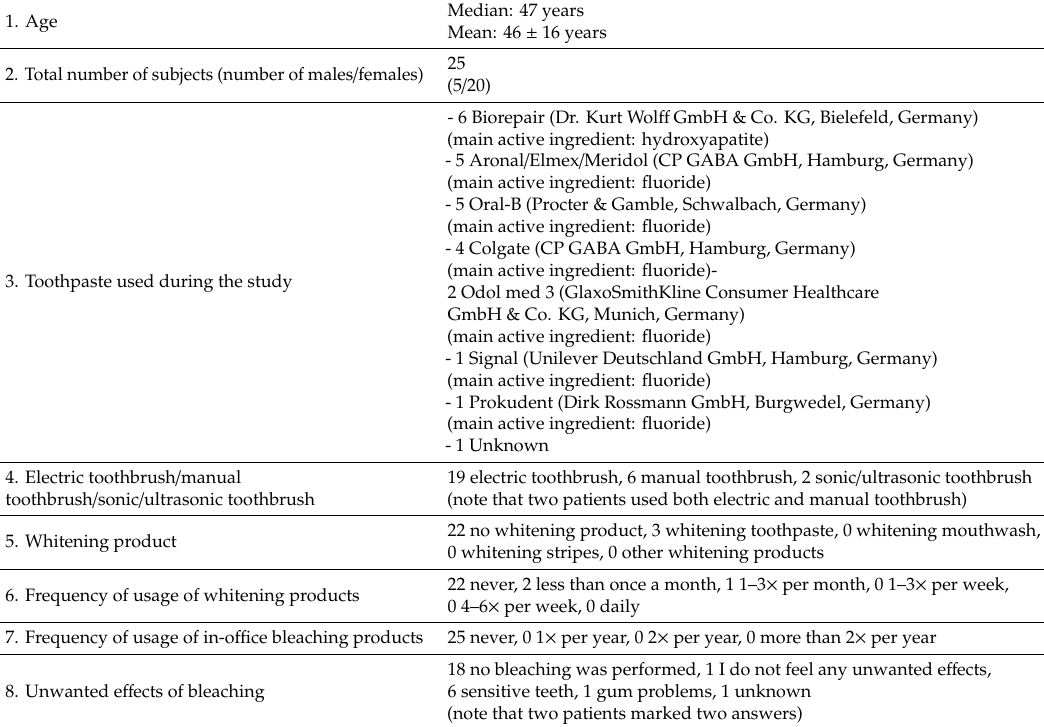
Table 2. Subjective parameters related to tooth color; baseline and follow-up (4 weeks) data (VAS = visual analogue scale). Table 3. Subjective parameters related to tooth sensitivity, tooth surface, and overall mouthfeel; baseline and follow-up (4-week) data (VAS = visual analogue scale).